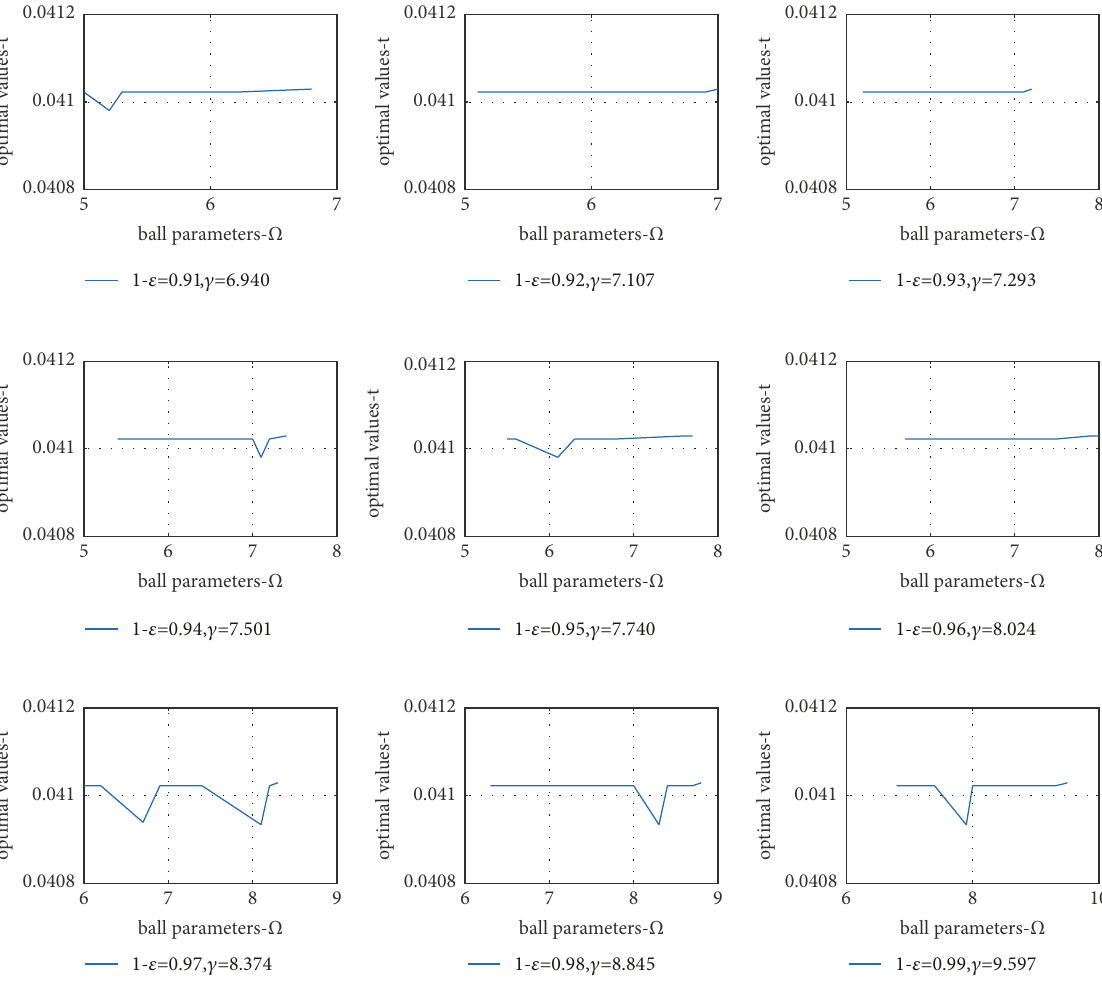
Figure 4: The comparison of the optimal values under different ball parameters- Ω